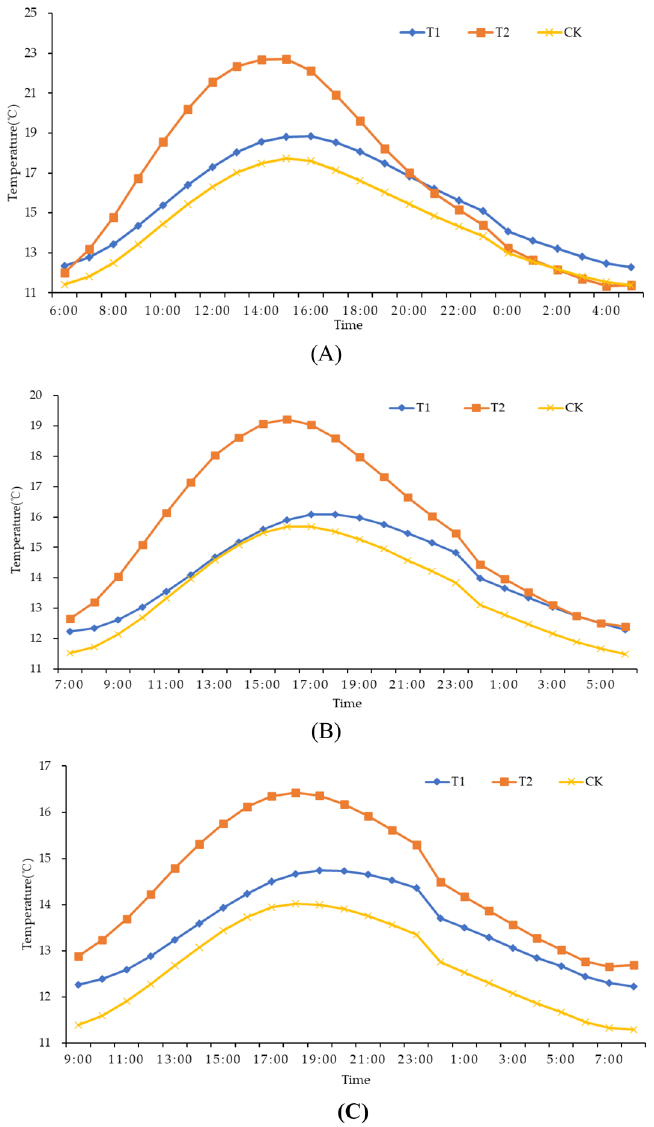
Figure 2. Daily soil temperature in different soil depth. ( A ) 50 mm soil depth. ( B ) 100 mm soil depth. ( C ) 150 mm soil depth.